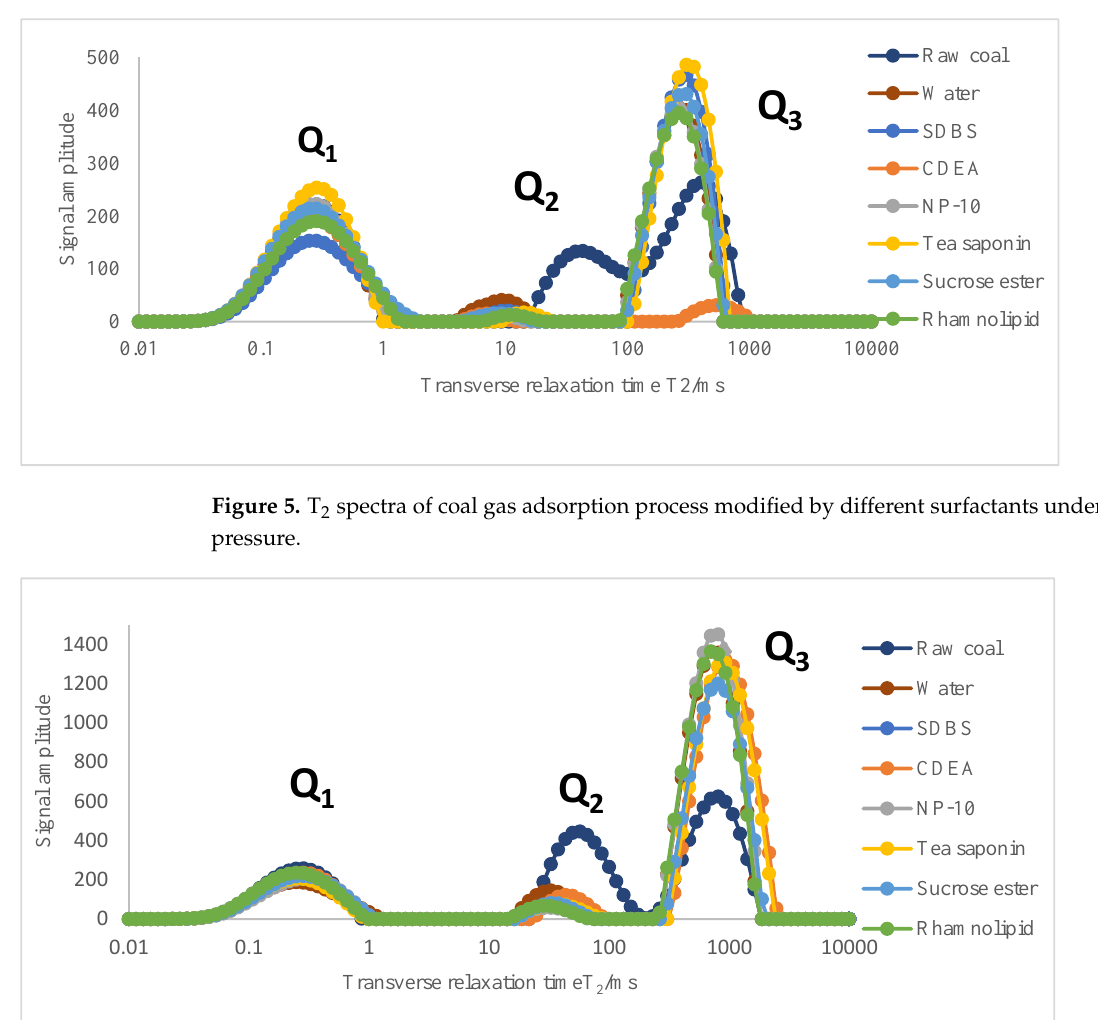
8 of 17 Figure 4. Conversion equation of methane marking (30 °C). 3.1.2. Analysis of NMR Spectroscopy Test Results of Coal Gas Adsorption At the set pressure point, the methane in coal was measured by NMR. According to